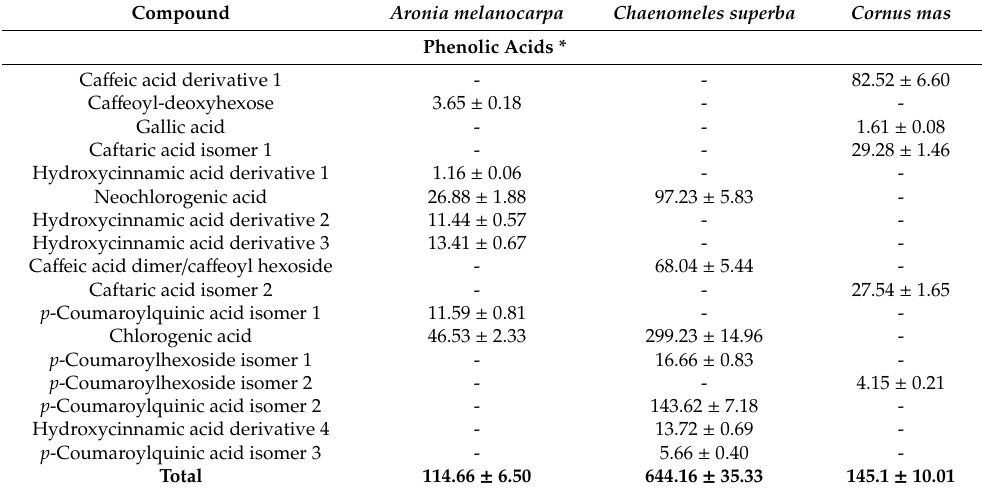
Table 3. Quantification of polyphenols and iridoids in leaf extracts ( µ g /